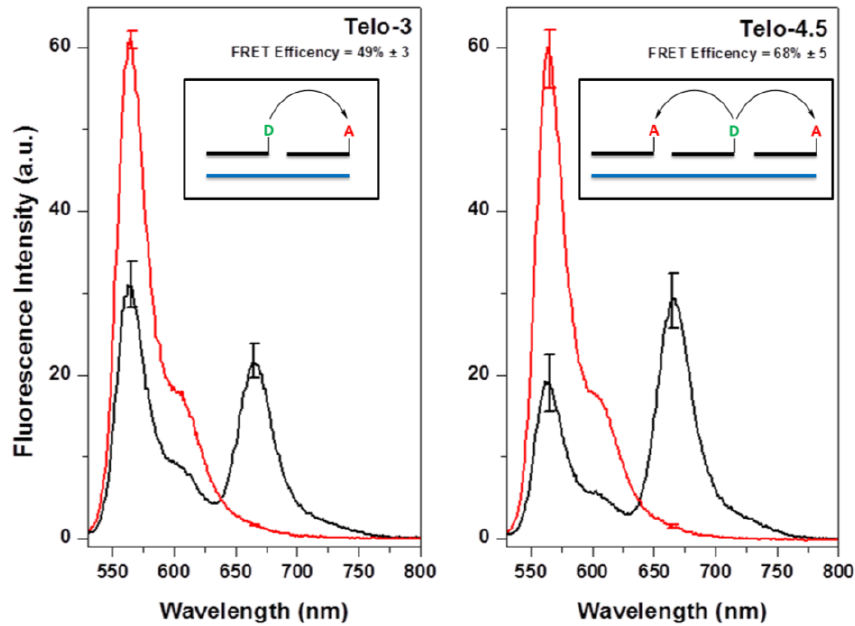
Figure 3. Förster resonance energy transfer (FRET) results for DNA oligonucleotides containing 3 ( left ) and 4.5 ( right ) telomeric repeats. Red curves are samples containing SCy3-γPNA and the unlabeled version of X647-γPNA; black curves correspond to samples with SCy3-γPNA and X647-γPNA with each DNA. Samples contained 200 nM DNA, 200 nM SCy3-γPNA, and either 200 nM X647-γPNA (Telo-3) or 400 nM X647-γPNA (Telo-4.5). Inset is a schematic representation of each DNA (blue) with donor (green) and acceptor (red) γPNAs.